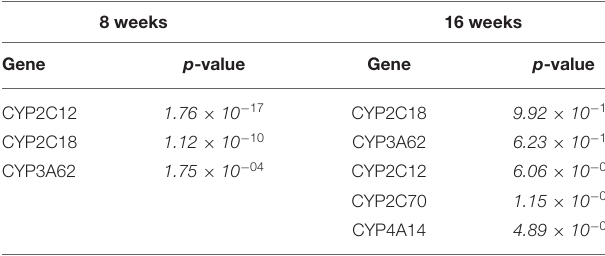
TABLE 2 | Downregulated CYP expression comparison between soy protein isolate (SPI) vs. casein (CAS) feeding at 8 and 16 weeks of diet. 8 weeks 16 weeks Gene